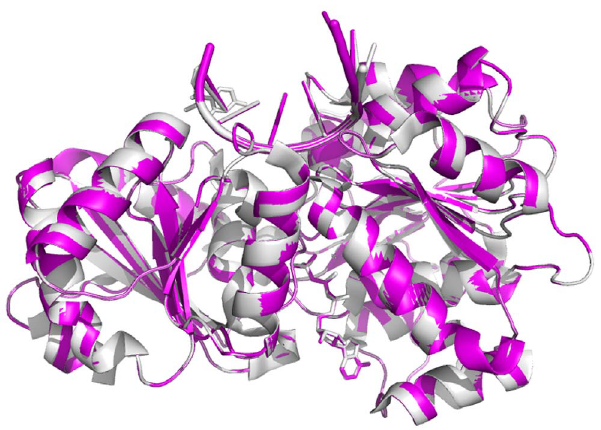
Figure 1. Superposition of two complexes. Superposition of the yeast ATP + RNA + C-eIF4A model (magenta) and the closed human eIF4AIII + ADPNP + RNA complex (gray, PDB-ID 2J0S) in the homology modeling.